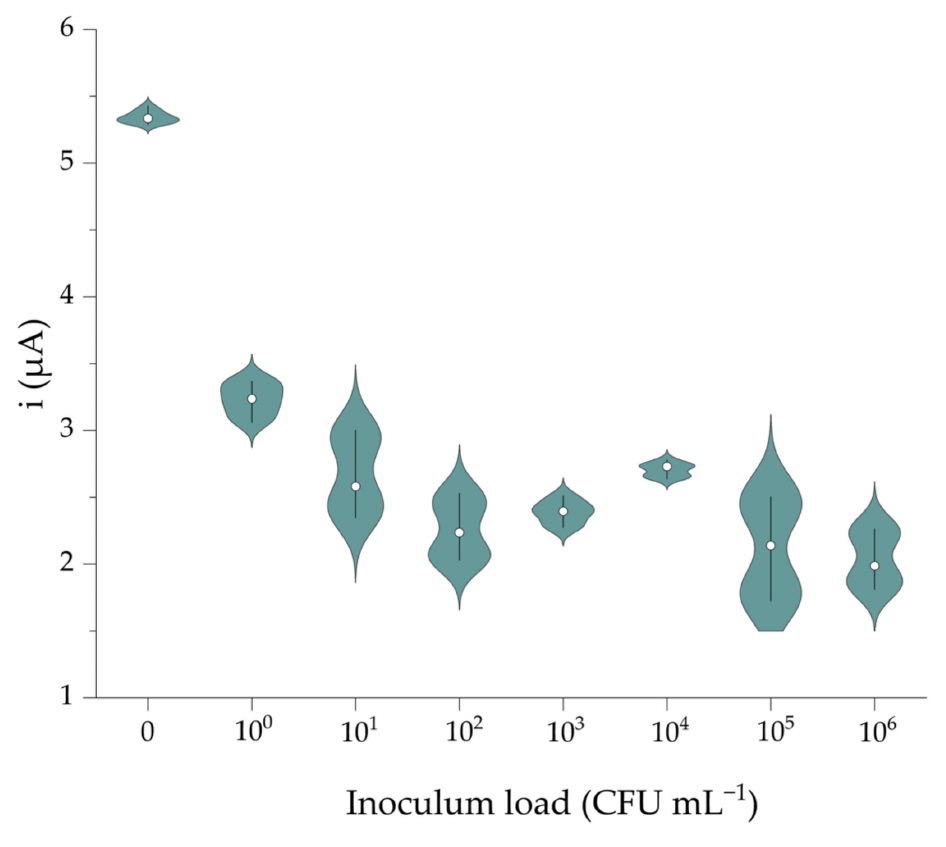
Figure 9. Endpoint electrochemical detection (square wave voltammetry) of LAMP amplicons obtained following P100–MBs mediated isolation and lysis of L. monocytogenes from spiked pasteurized